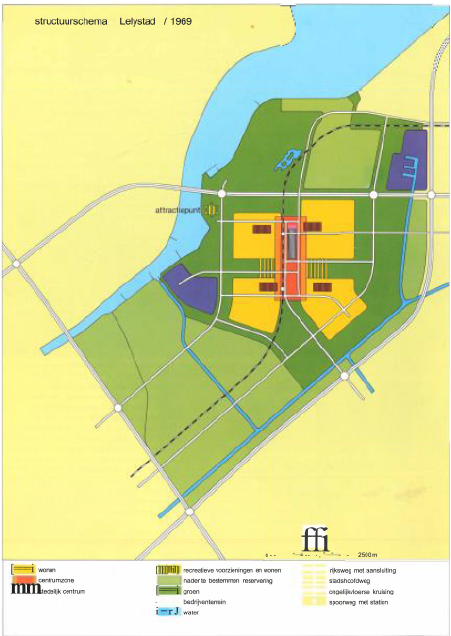
Figure 6. Structure scheme 1969.